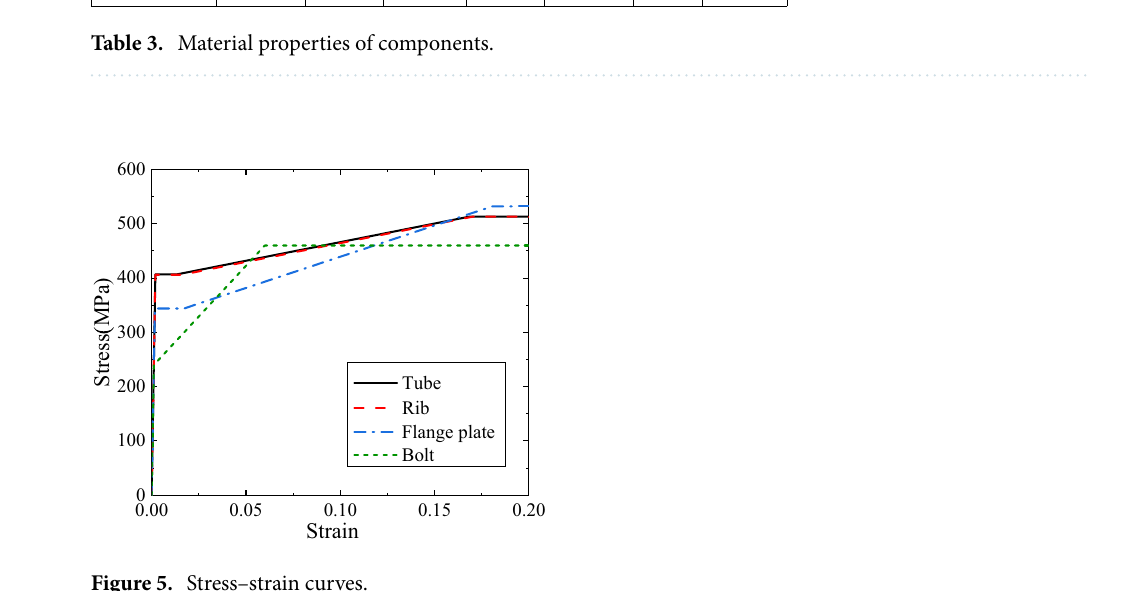
Figure 5. Stress–strain curves.